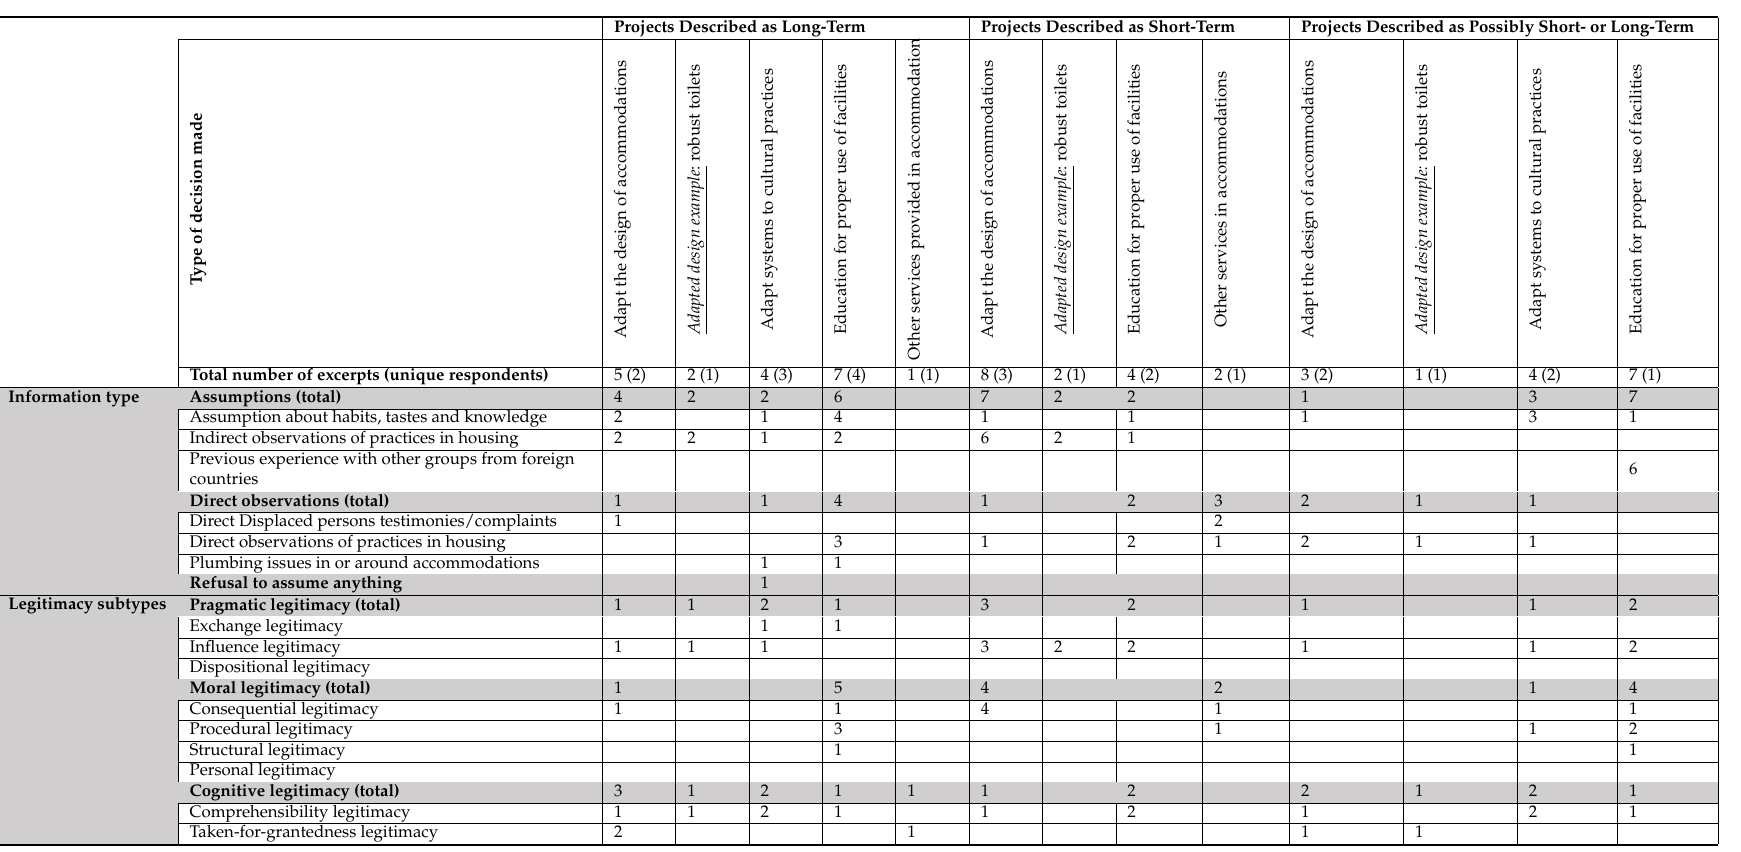
Table A1. Decisions made and legitimacy used while legitimizing the inclusion of cultural